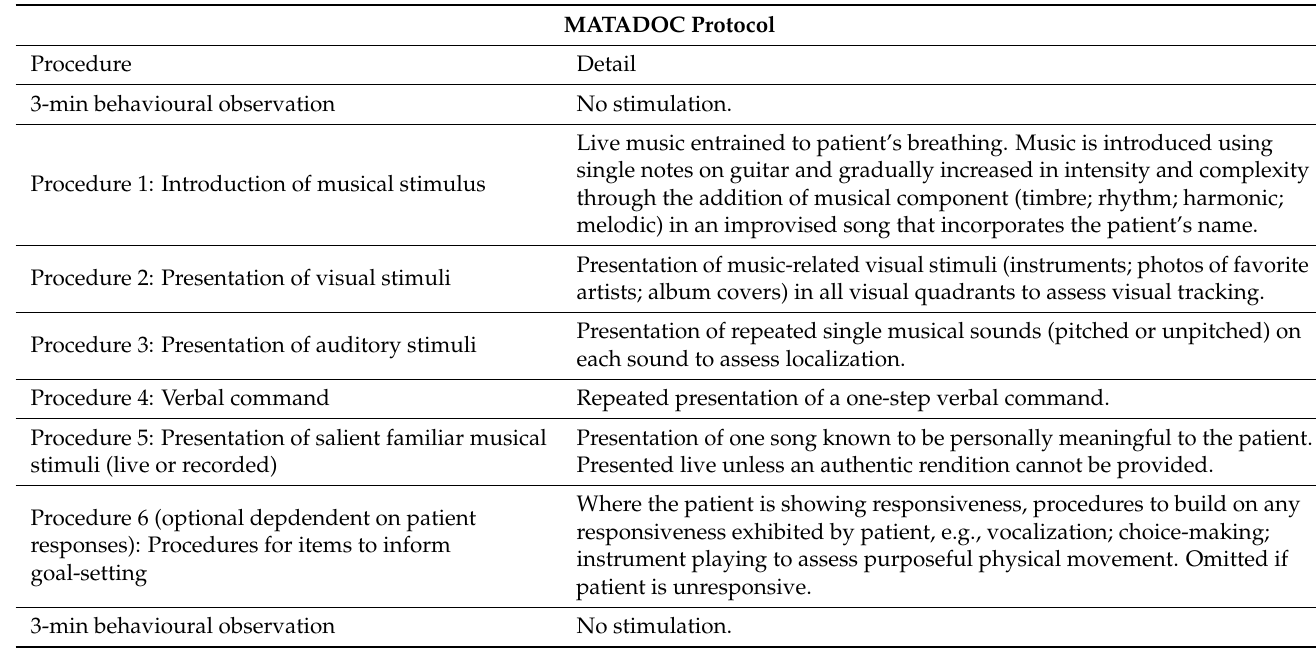
Table 1. The MATADOC